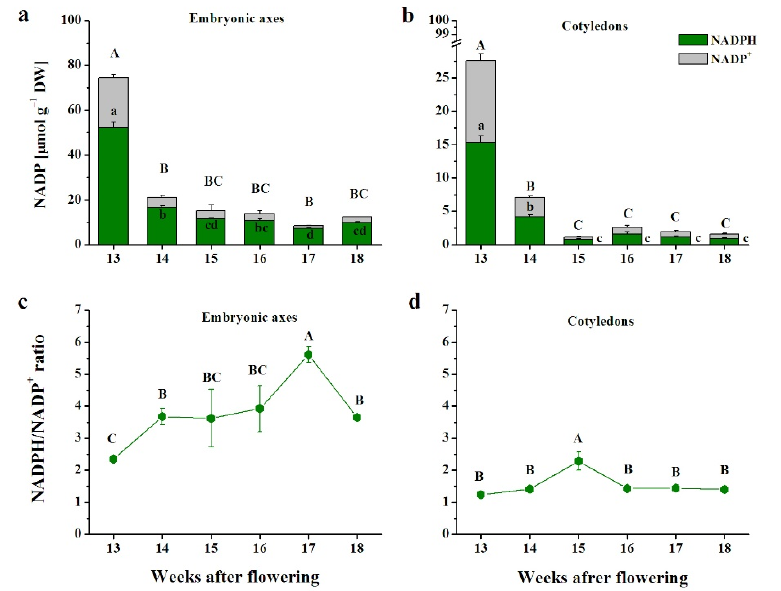
Figure 4. Nicotinamide adenine dinucleotide (NADP) levels ( a , b ) and the ratio of NAD reduced to the oxidized form (NADPH/NADP + ) ( c , d ) in embryonic axes ( a , c ) and cotyledons ( b , d ) of developing beech seeds. Data are the means of three independent replicates ± the standard error. Statistically significant differences are indicated with different letters (one-way ANOVA, followed by Tukey’s test at p < 0.05). The capital letters refer to NADP + .